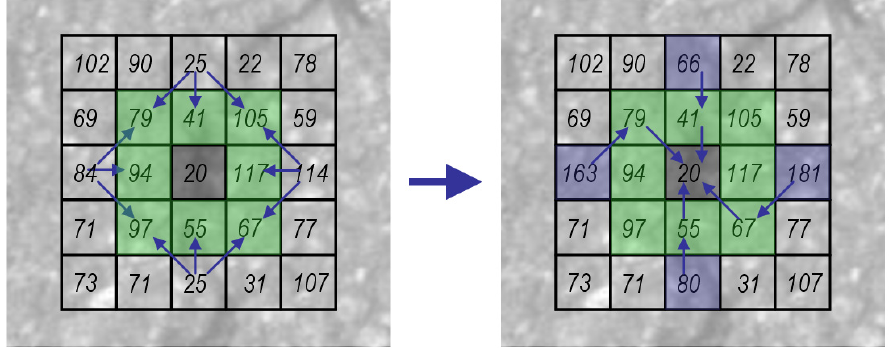
Figure 14. Iterative process: distance cost computation of pixels located on x-y -axis. Left : possible neighbor pixels locations. Right : distance costs and backtracking information.